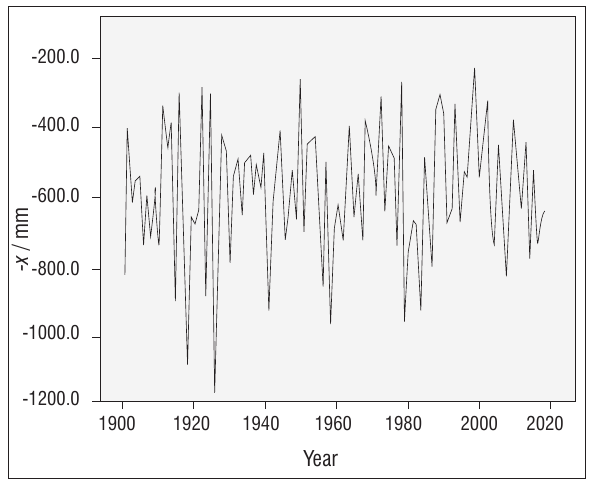
Figure 2: Time series plot of the -x 1901 to 2009. Unit root test for stationarity